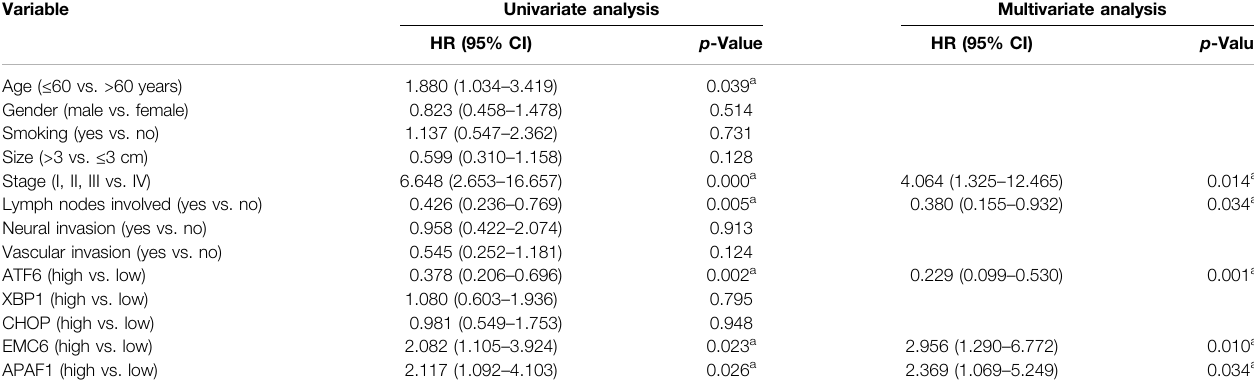
TABLE 3 | Univariate and multivariate Cox regression analysis for overall survival.